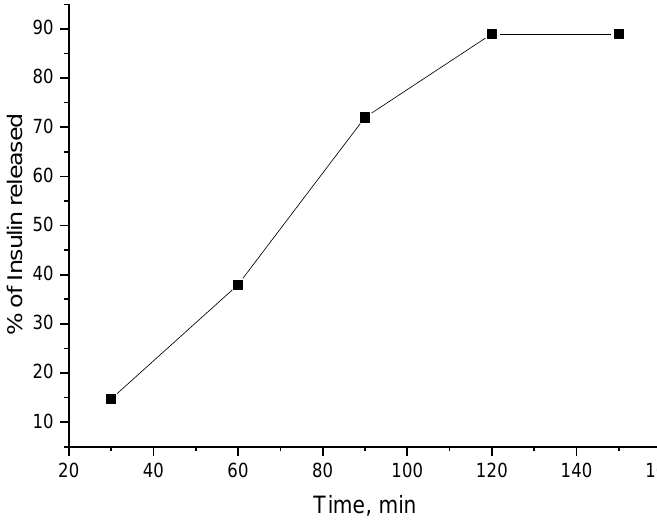
Figure 6. Insulin release profile upon incubation in PBS buffer (pH 7.4) at 37 °C; redrawn from [63].